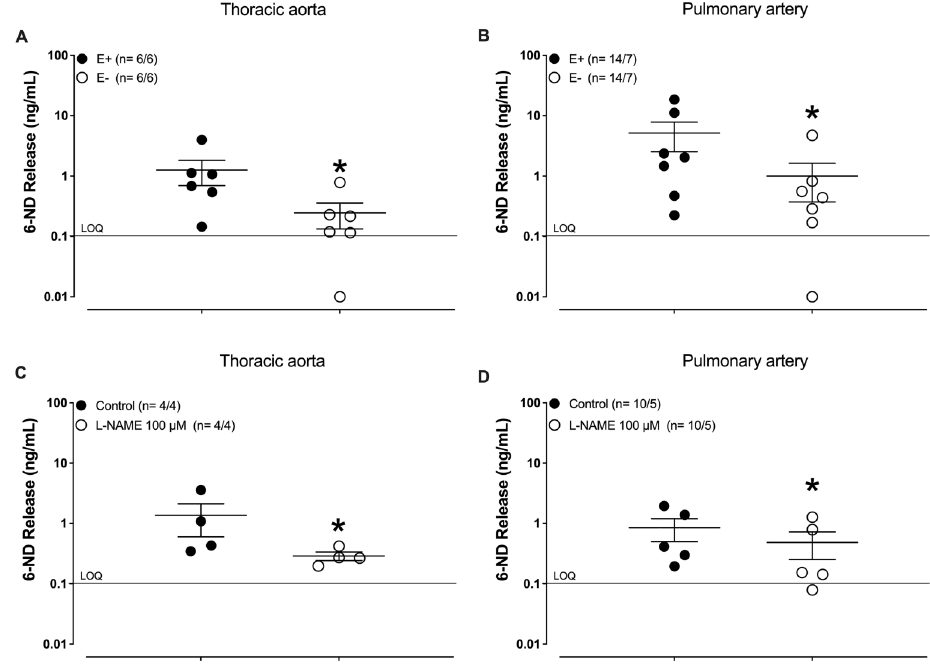
Figure 1. Basal release of 6-nitrodopamine (6-ND) from thoracic aorta and pulmonary artery rings. Panels A and B show the effect of endothelium removal (E-) on the basal release of 6-ND from thoracic aorta (n=6/6) and pulmonary artery (n=14/7), respectively. Panels C and D show the effect of pre-incubation (30 min) of L-NAME (100 m M) on basal release of 6-ND from thoracic aorta (n=4/4) and pulmonary artery (n=14/7), respectively. The number of experiments (n) is reported as x/y, where x represents the number of animals and y the number of rings employed. Data are reported as means ± SE. *P o 0.05 (Student ’ s unpaired t